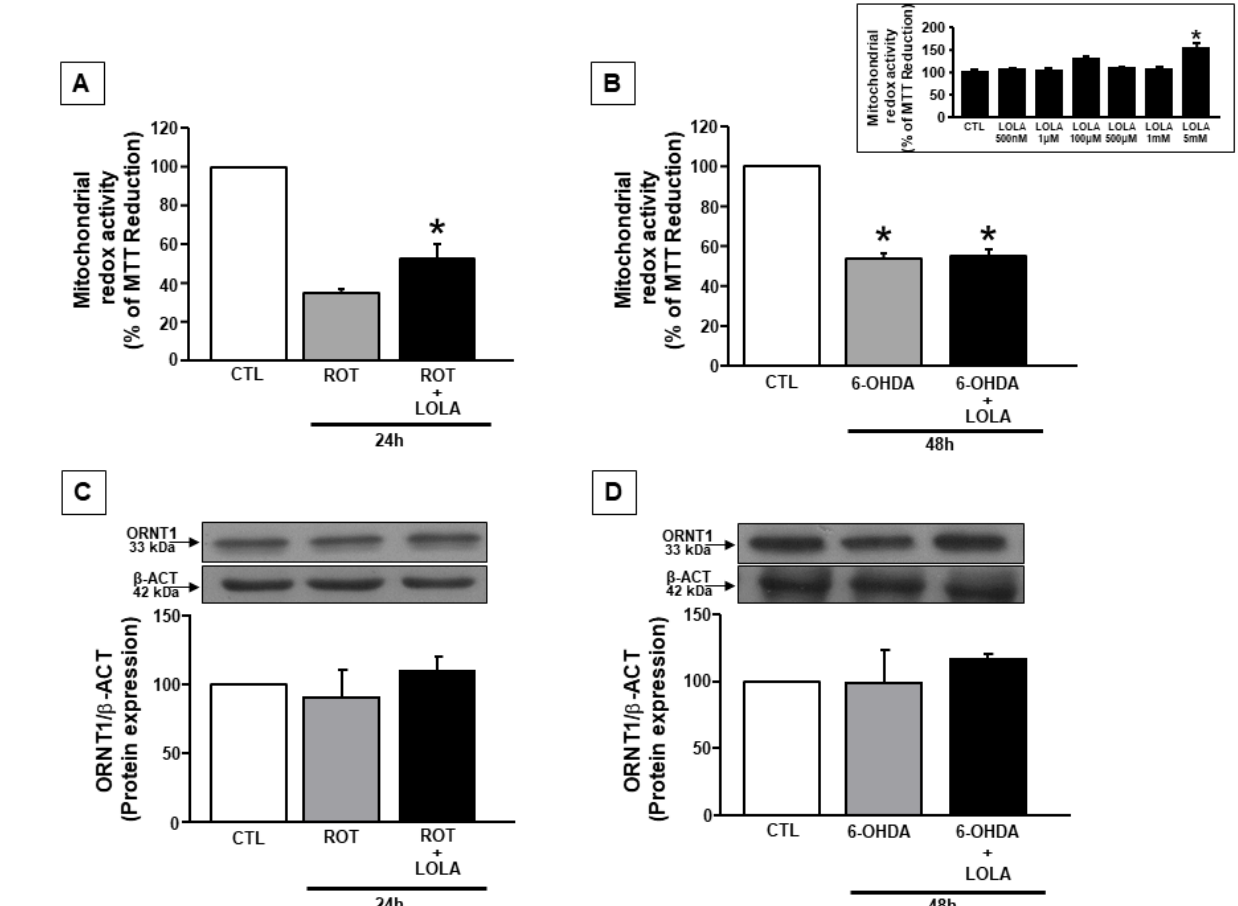
Figure 1. Mitochondrial redox activity in SH-SY5Y cells exposed to ROT and 6-OHDA and treated with LOLA: ( A ) Mitochondrial redox activity in cells treated with ROT (500 nM/24 h) and ROT+LOLA (5 mM/24 h). * p < 0.05 vs. ROT. ( B ) Mitochondrial redox activity in cells treated with 6-OHDA (30 µ M/48 h) and 6-OHDA+LOLA; * p < 0.05 vs. CTL. (Inset) Dose-response of LOLA treatment for 24 h on mitochondrial redox activity in basal conditions. * p < 0.05 vs. CTL. ( C ) Expression of the ornithine transporter 1 (ORNT1) after exposure to ROT. ( D ) Expression of the ornithine transporter 1 (ORNT1) after exposure to 6-OHDA. The values for each column represent the mean of the percentage ± SEM.